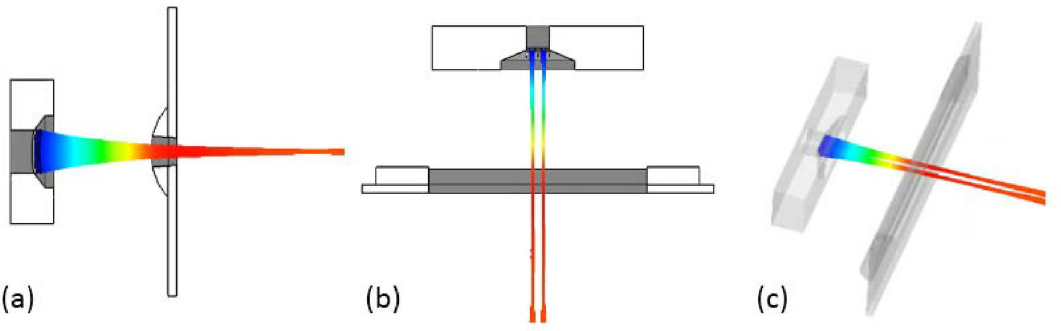
Figure 6. Beam trajectory of the double-beam gun. ( a ) y-o-z plane. ( b ) x-o-z plane. ( c ) 3D